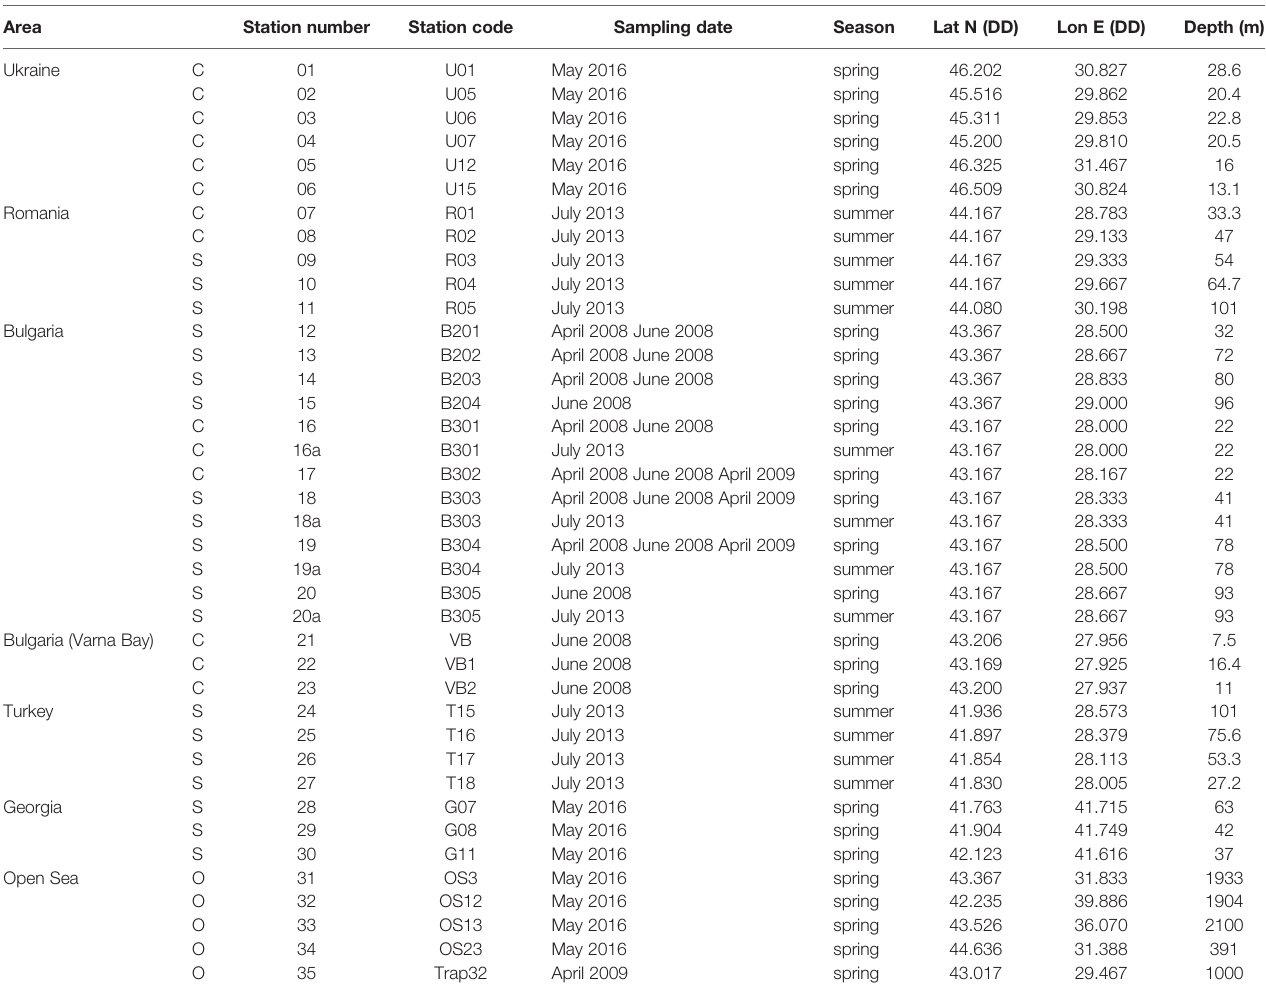
TABLE 1 | Sampling stations (location, sampling date, season, geographic coordinates, depth).